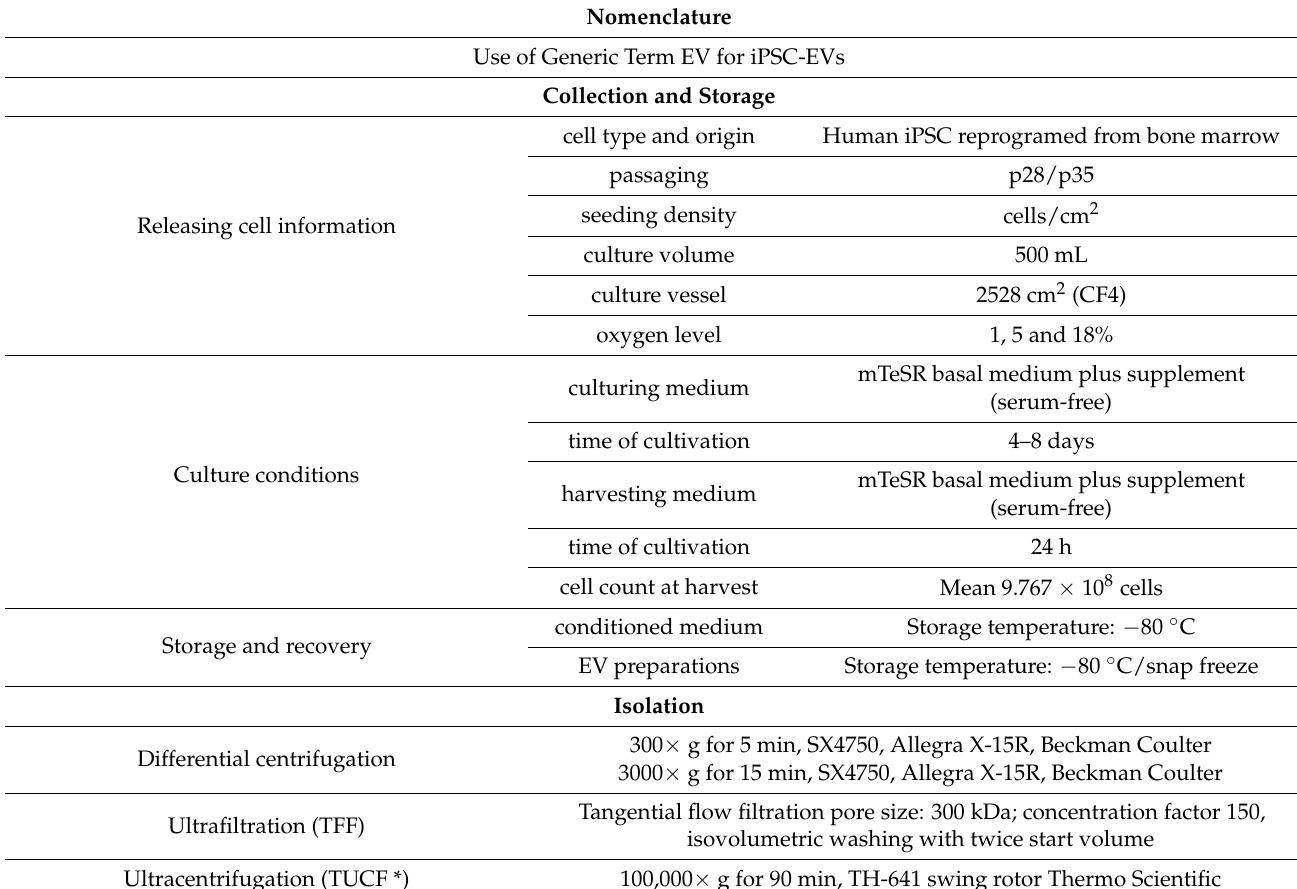
Table A2. Adherence to MISEV2018 criteria for research with EV